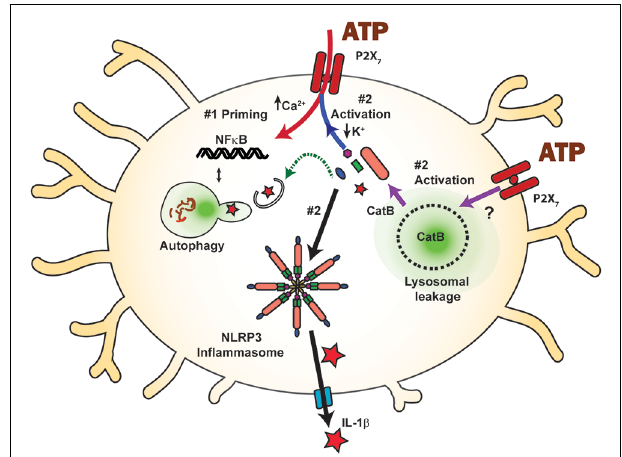
FIGURE 2 | Inflammasome activation by the P2X 7 receptor and the balance between priming and autophagic degradation of inflammasome components. Stimulation of the P2X 7 receptor triggers the assembly and activation (step #2) of the NLRP3 inflammasome following efflux of K + through the open channel (blue arrow), eventually leading to cleavage of pro-IL-1 β (red star) into the mature form and release through the gasdermin D pore (blue). The P2X 7 receptor can also activate the NLRP3 inflammasome and subsequent IL-1 β release by raising cytoplasmic cathepsin B (CatB), following its initiation of lysosomal leakage through an unknown mechanism (purple arrows). P2X 7 receptor stimulation can prime inflammasome components via NF- κ B (step #1, red arrow) and increase available inflammasome components. Component levels can also be decreased following autophagic degradation (green arrow), limiting the inflammatory potential of P2X 7 receptor stimulation. The balance between priming and autophagic degradation will influence the inflammatory impact of P2X 7 receptor